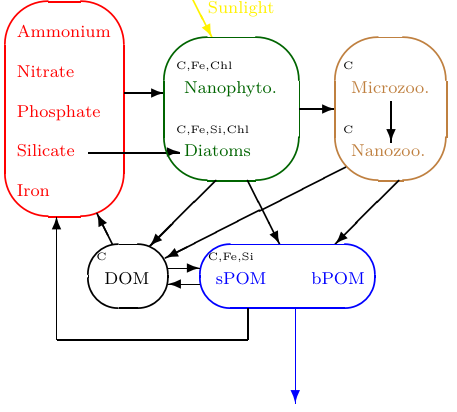
Figure 1. The biogeochemical model PISCES. DOM stands for dissolved and POM for particulate organic